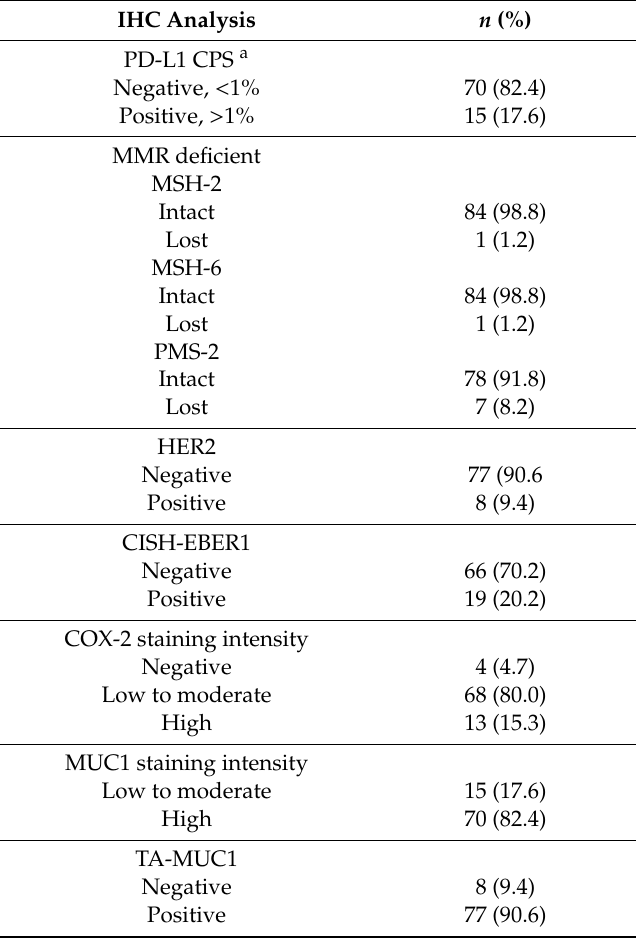
Table 4. Immunohistochemistry tumor analysis ( n =